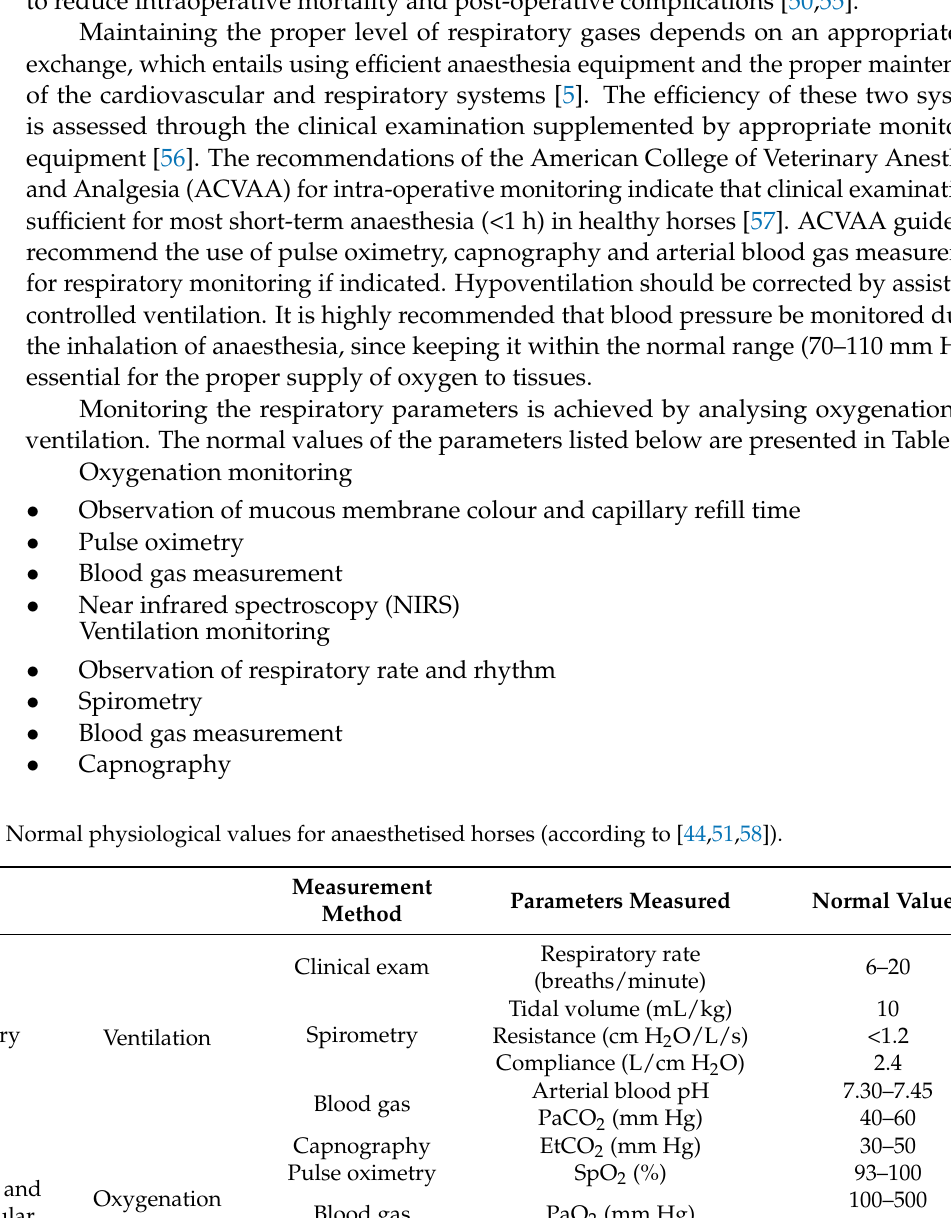
Function of the